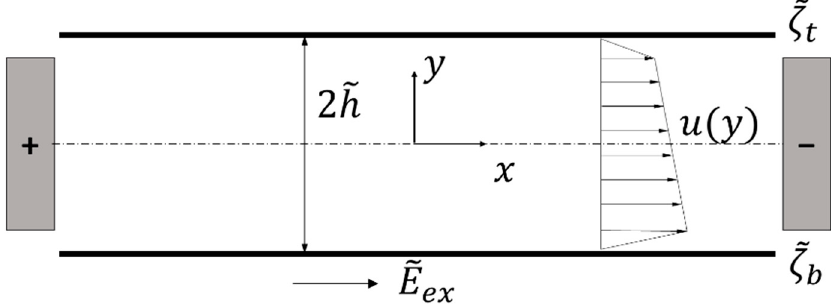
Figure 1. Schematic diagram of electroosmotic flow in a slit microchannel.